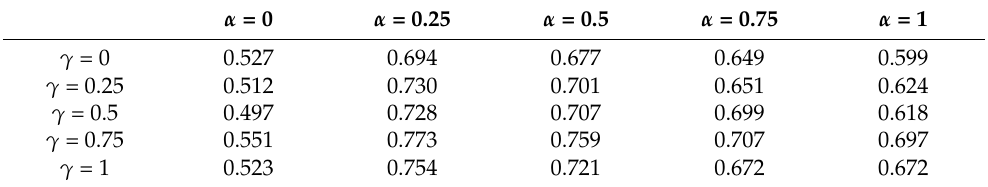
Table 1. AP values of the experiment under different hyperparameters α and γ .